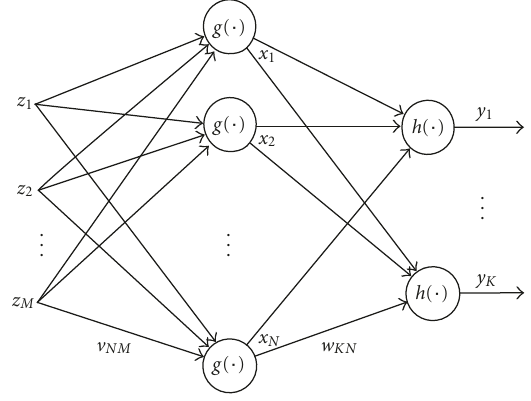
Figure 1: A single hidden layer MLP